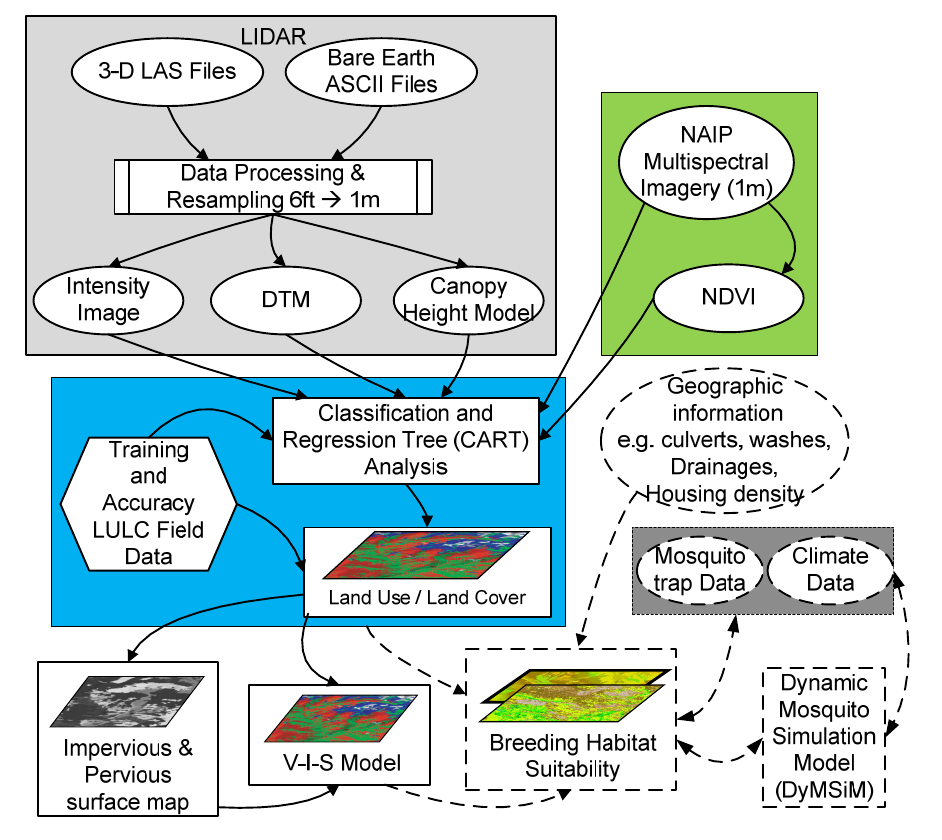
Figure 2. Overview of urban mosquito habitat mapping and modeling phases. The LIDAR and multispectral data processing steps are used as input to the CART based LULC classification. The LULC is used to derive a Vegetation, Impervious and Soil (V-I-S) map [10]. These map products contribute to mosquito habitat and simulation (outlined with dashed lines and arrows) and development of urban mosquito abundance